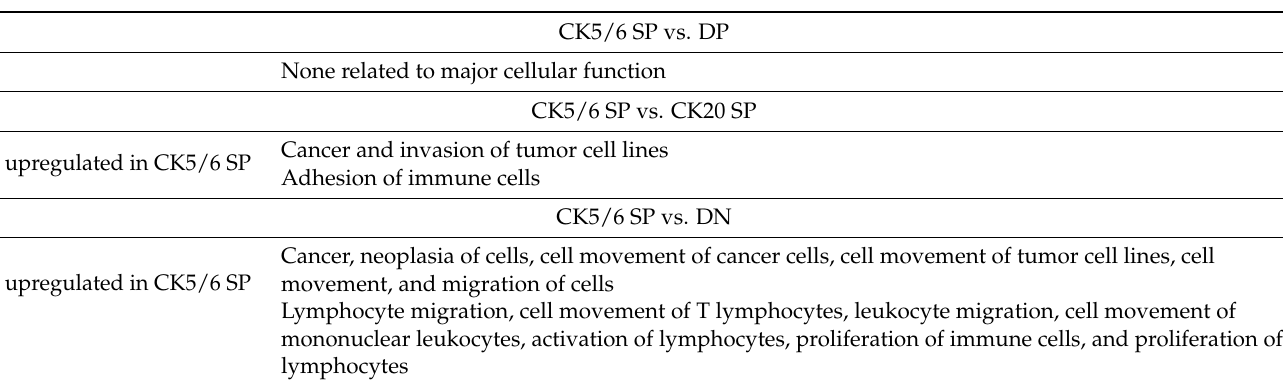
Table 3. The ingenuity pathway analysis results (disease and